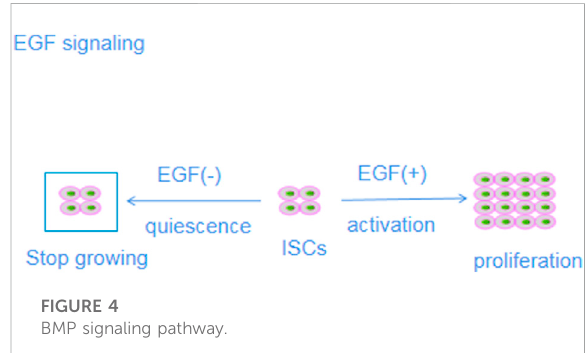
FIGURE 4 BMP signaling